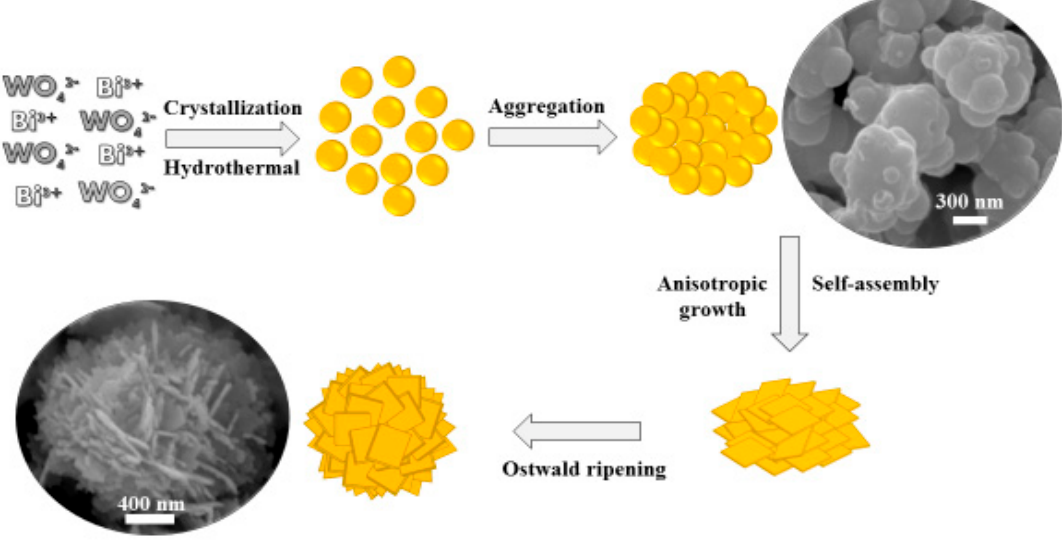
Table 3. Brunauer–Emmett–Teller (BET) parameters of the Bi 2 WO 6 samples at various temperatures. Samples